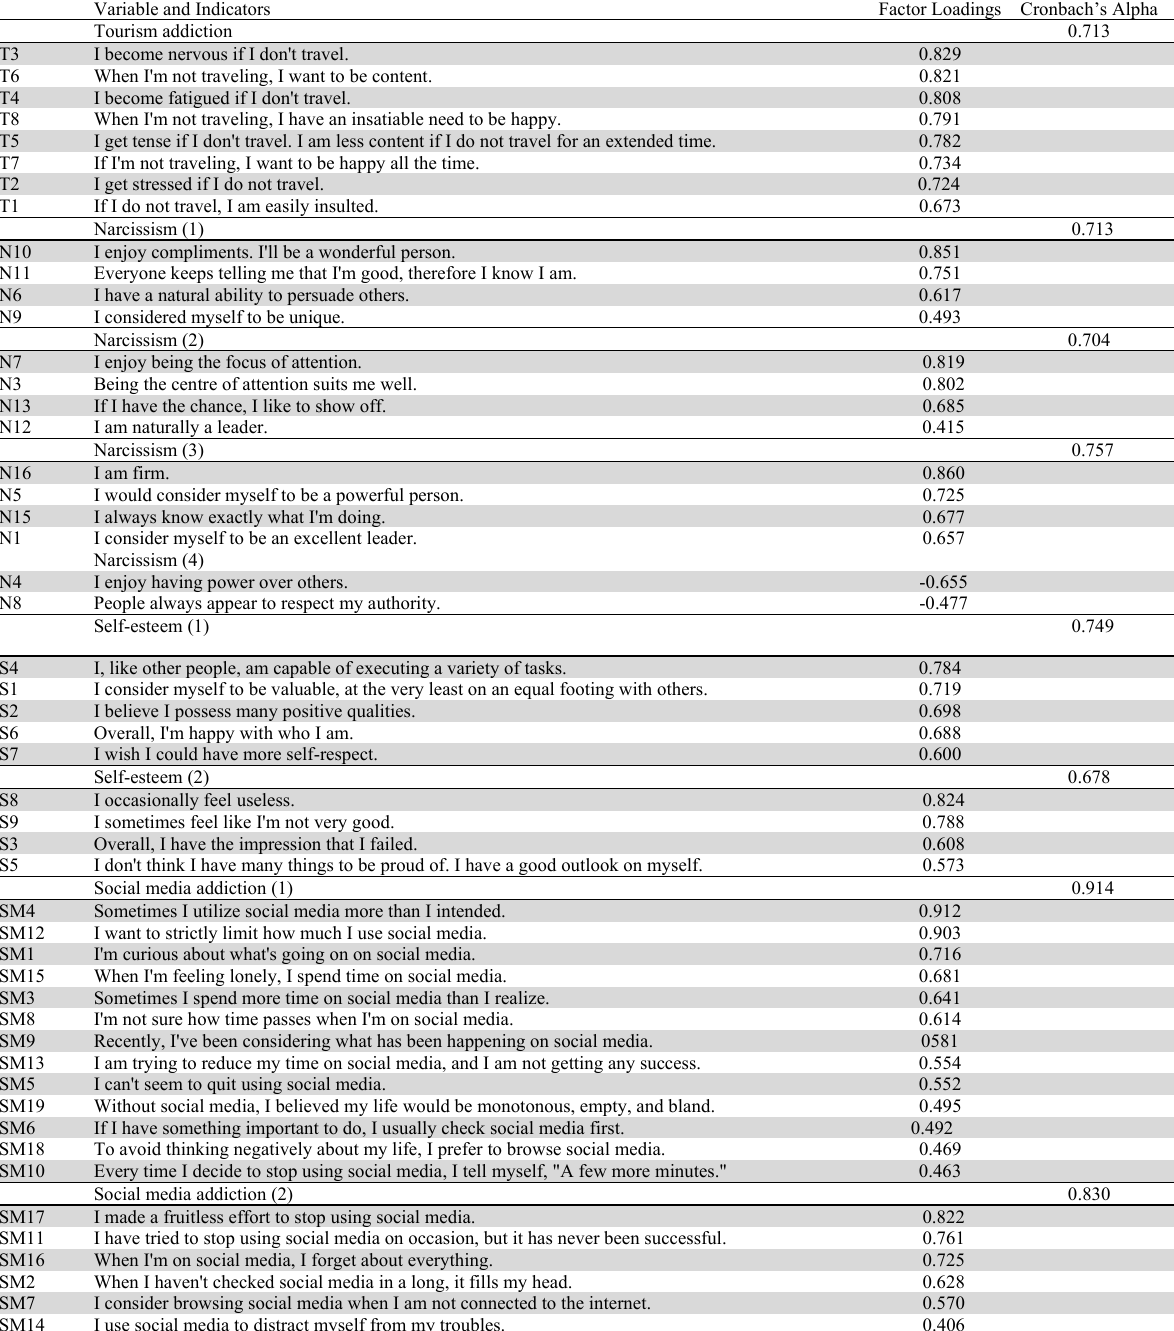
two components: The first component had 5 indicators with an alpha value of 0.749. The second component had 4 with an alpha of 0.678. In addition, social media is further divided into two parts: the first part stored 13 indicators with an alpha value of 0.914. The second component of social media addiction also included six indicators with an alpha value of 0.830. Table 3 Results of Validity and Reliability Tests Variable and